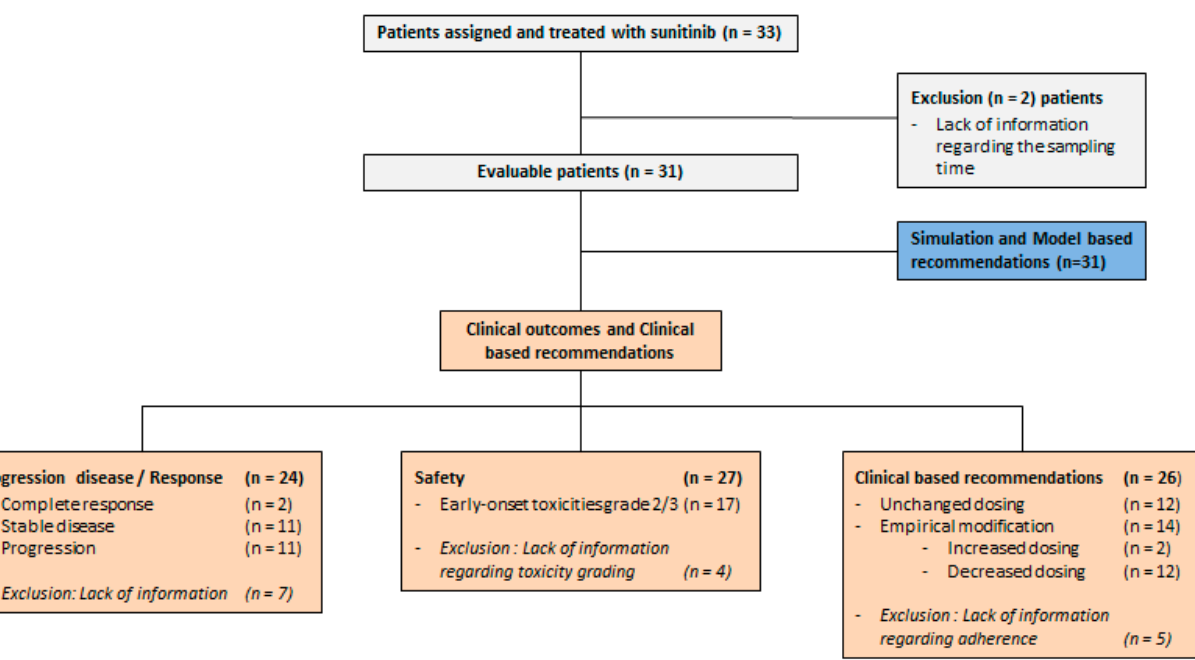
Figure 1. Flowchart of the observational study. Table 1. Patients’ baseline demographics and clinical characteristics.